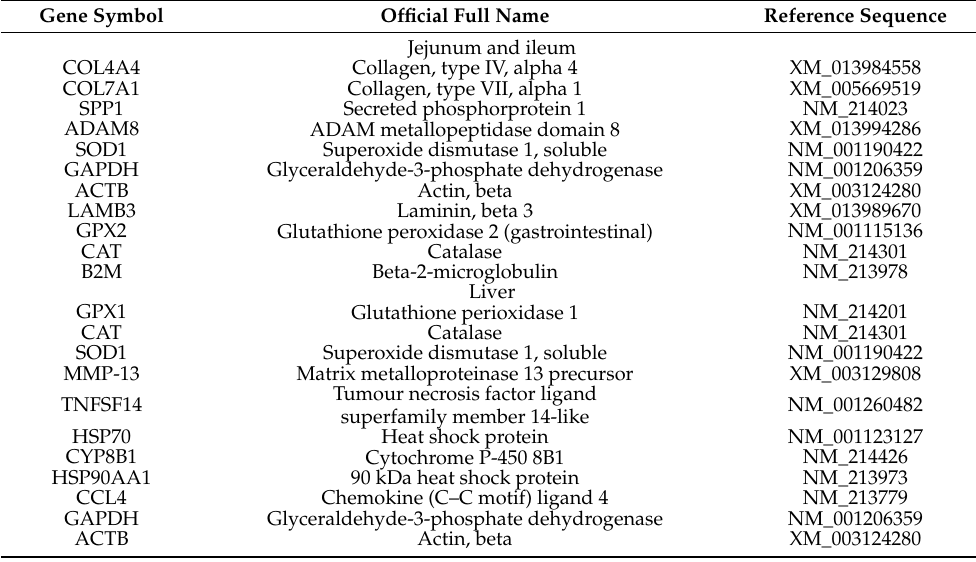
Table 1. Reference and selected genes used for analyses of gene